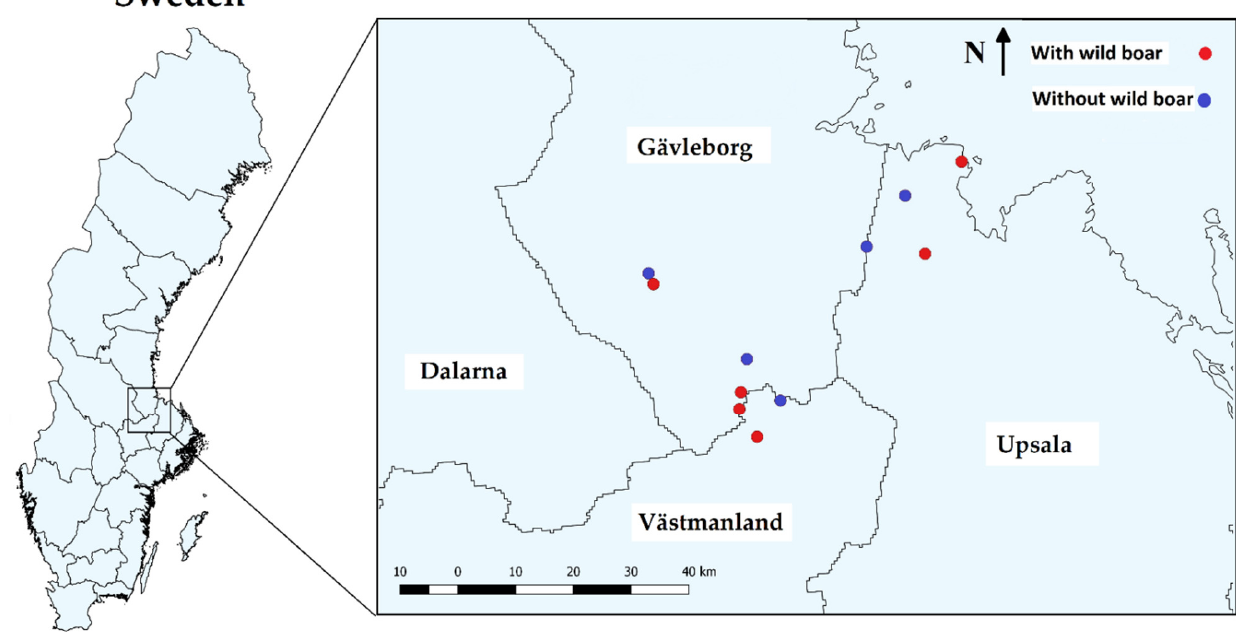
Figure 1. Location of study plots of wild boar-fungal interactions in Gävleborg, Uppsala and Väst- manland, central Sweden. Plots with wild boar (red) and without wild boar (blue). Performed using the software QGIS version